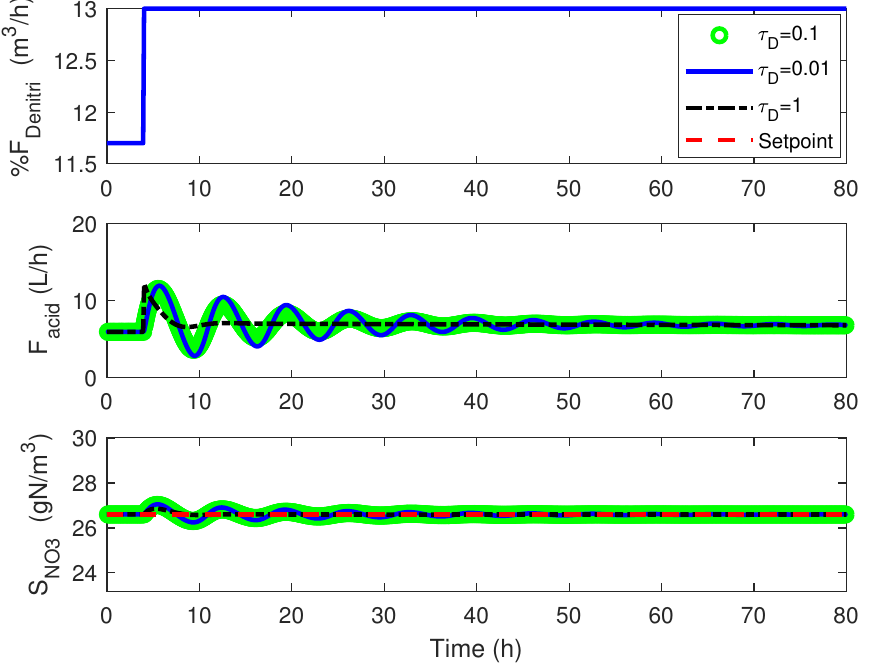
Figure 7. Selection of the PID derivative gain τ D